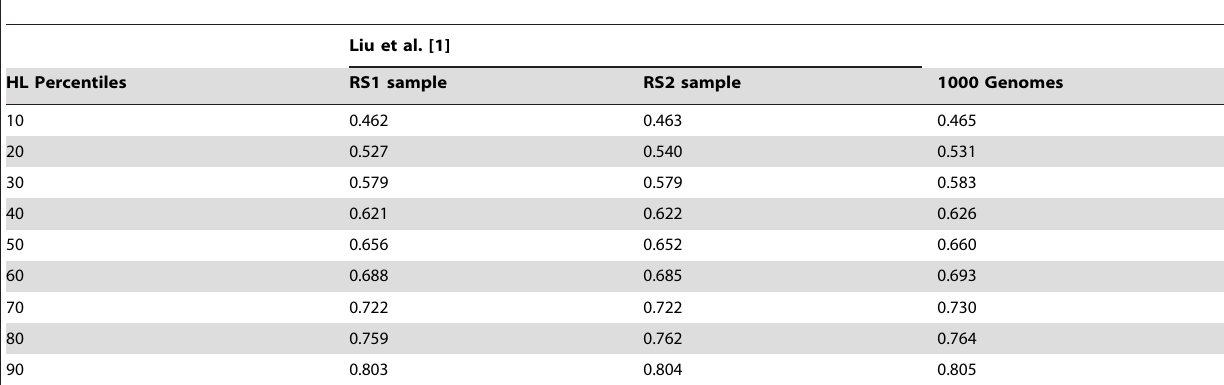
Table 3. Distribution of HL for the RS1 and RS2 samples used by Liu et al. [1] and the 1000 Genomes populations.